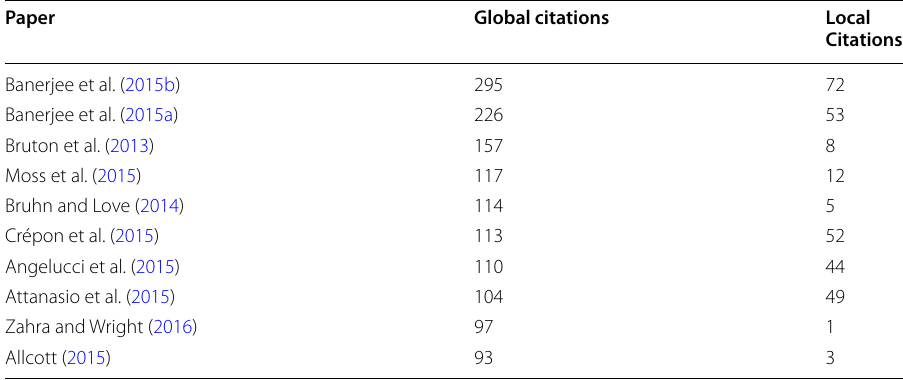
Table 6 Top 10 cited articles based on global and local citations on sample statistics of 524 papers, published between 1:2012 and